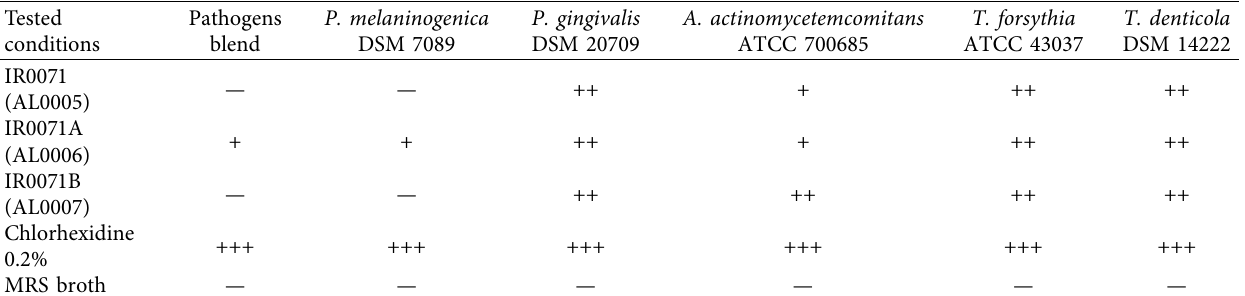
Table 8: Results of agar diffusion well assay to assess antibacterial properties of the lipogel-bacteria preparations.